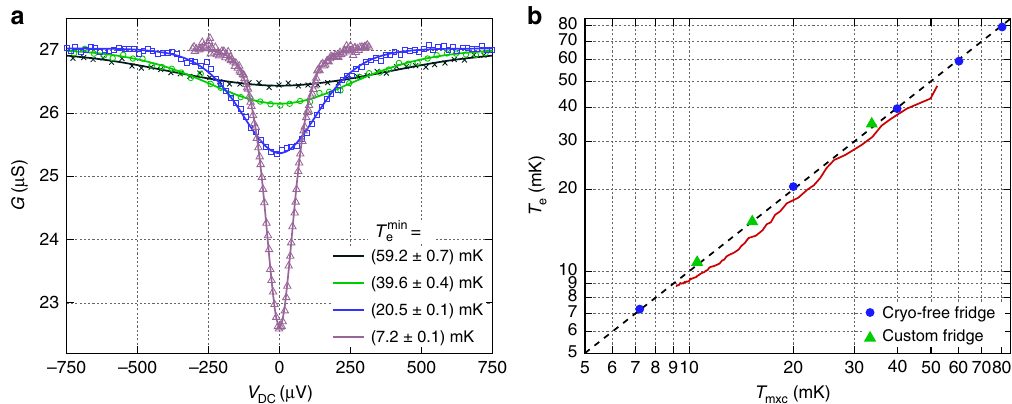
Figure 2 | CBT behaviour between 80 and 7mK in two dilution refrigerators. ( a ) CBT conductance G versus measured bias voltage V DC at four temperatures. Symbols show measured values and lines show best fits to the calculated ideal conductance. The warmest measurements (crosses, circles and squares) are fitted simultaneously to calibrate the sensor, giving C S ¼ 236.6 fF and R T ¼ 22.42k O . The coldest measurement (triangles) is fitted using are in close agreement with the refrigerator temperature measured by a RuO 2 thermometer: this calibration. The minimum electron temperatures T min e 59.9, 40.1, 20.0 and 7.2mK respectively. The uncertainties on T min are calculated from uncertainties in the fitted parameters. ( b ) CBTelectron temperature e T e versus refrigerator temperature T mxc . Symbols show T min from fits to conductance dips measured in the cryogen-free refrigerator (circles) and the e custom refrigerator (triangles). Error bars are within the symbols. The solid curve shows T e determined by monitoring the conductance G 0 (at V DC ¼ 0) as the cryo-free fridge cools over 35min from 52 to 9mK, showing that the CBT has a stronger thermal link to the refrigerator than the RuO 2 thermometer, leading to the thermal lag ( T mxc Z T e ) during this time. The dashed line shows T e ¼ T mxc